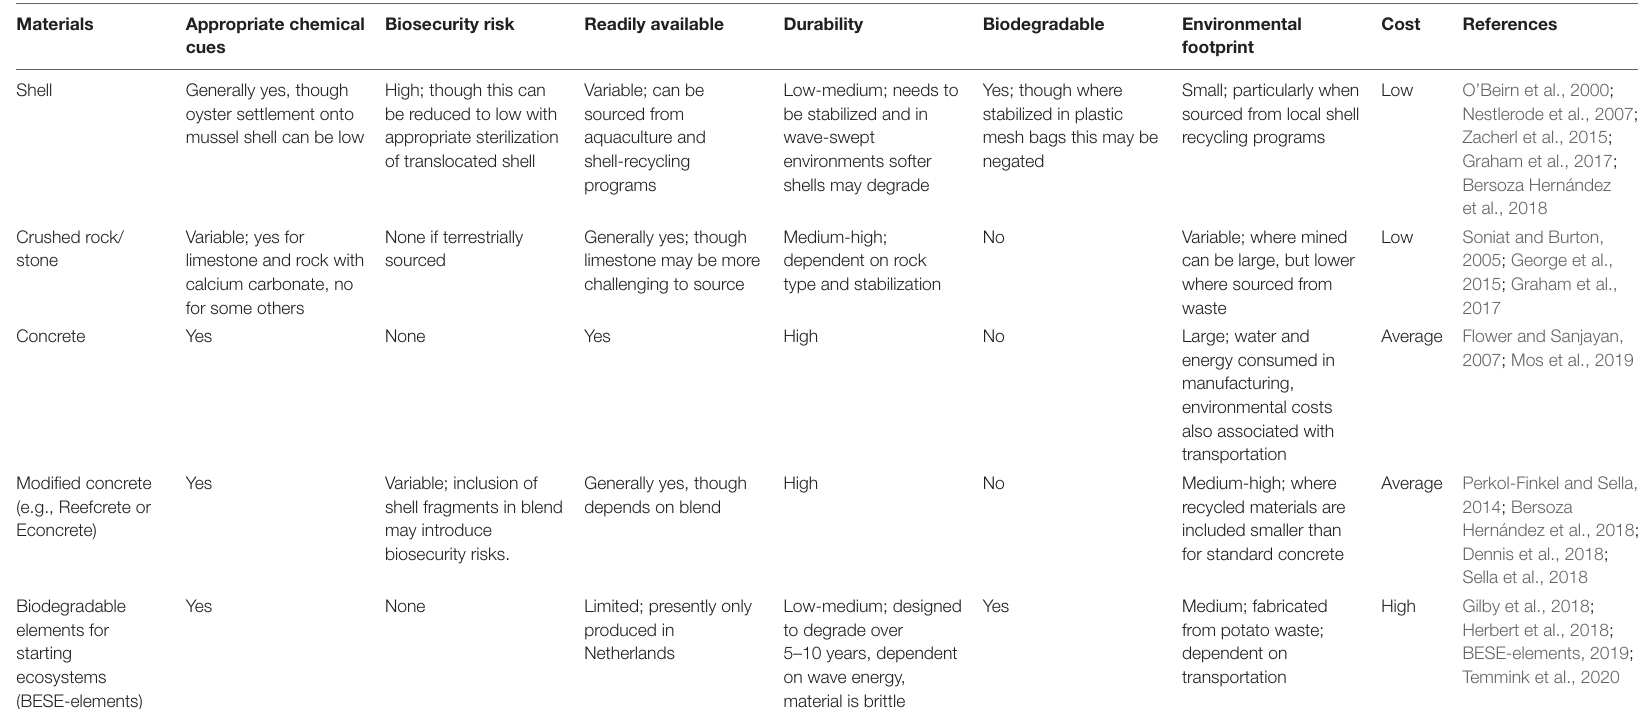
TABLE 2 | Performance of substrates against key criteria for oyster reef